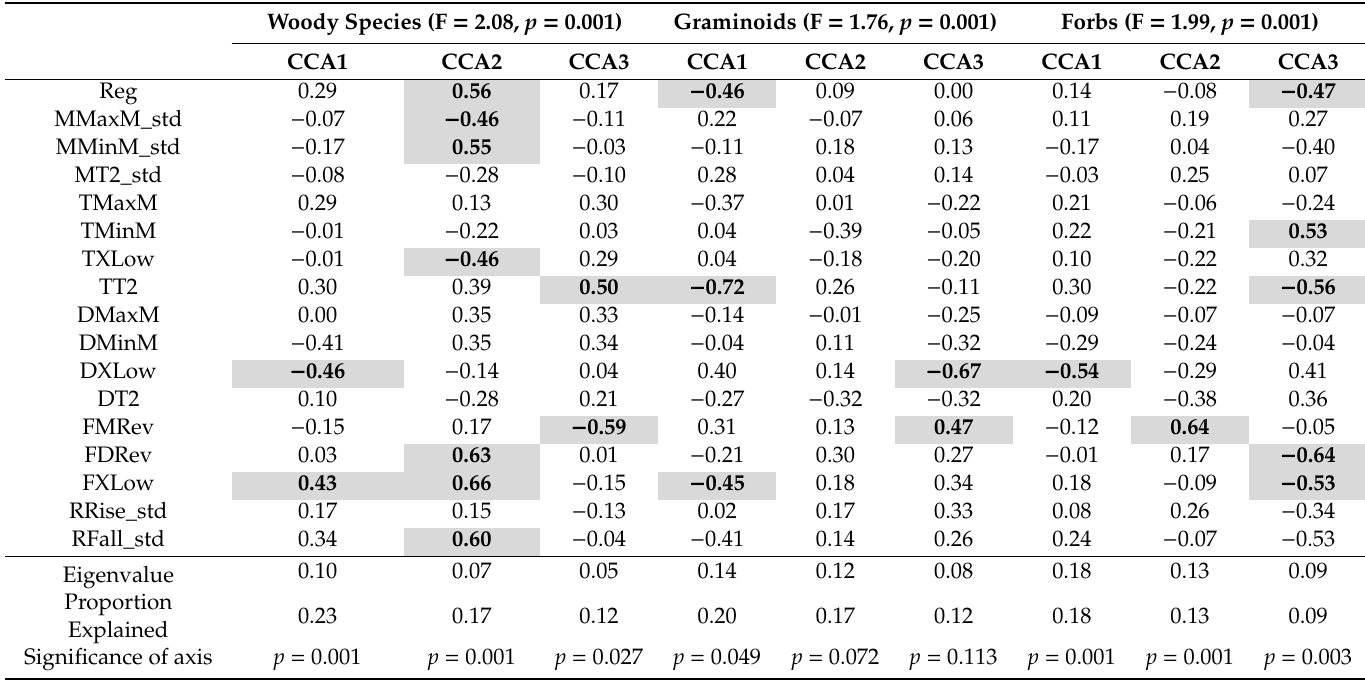
Table 2. Summary table of the variable loadings and cumulative variance explained of the first three axes of the CCA, separated for woody, graminoid, and forb species distribution data. In addition, the significance of each axes in each CCA is provided (bottom row), as is that of the CCA as a whole (top row). For an explanation of the hydrological variable names see Table 1 and Annex 1. We highlight the cells (bold) with loadings beyond